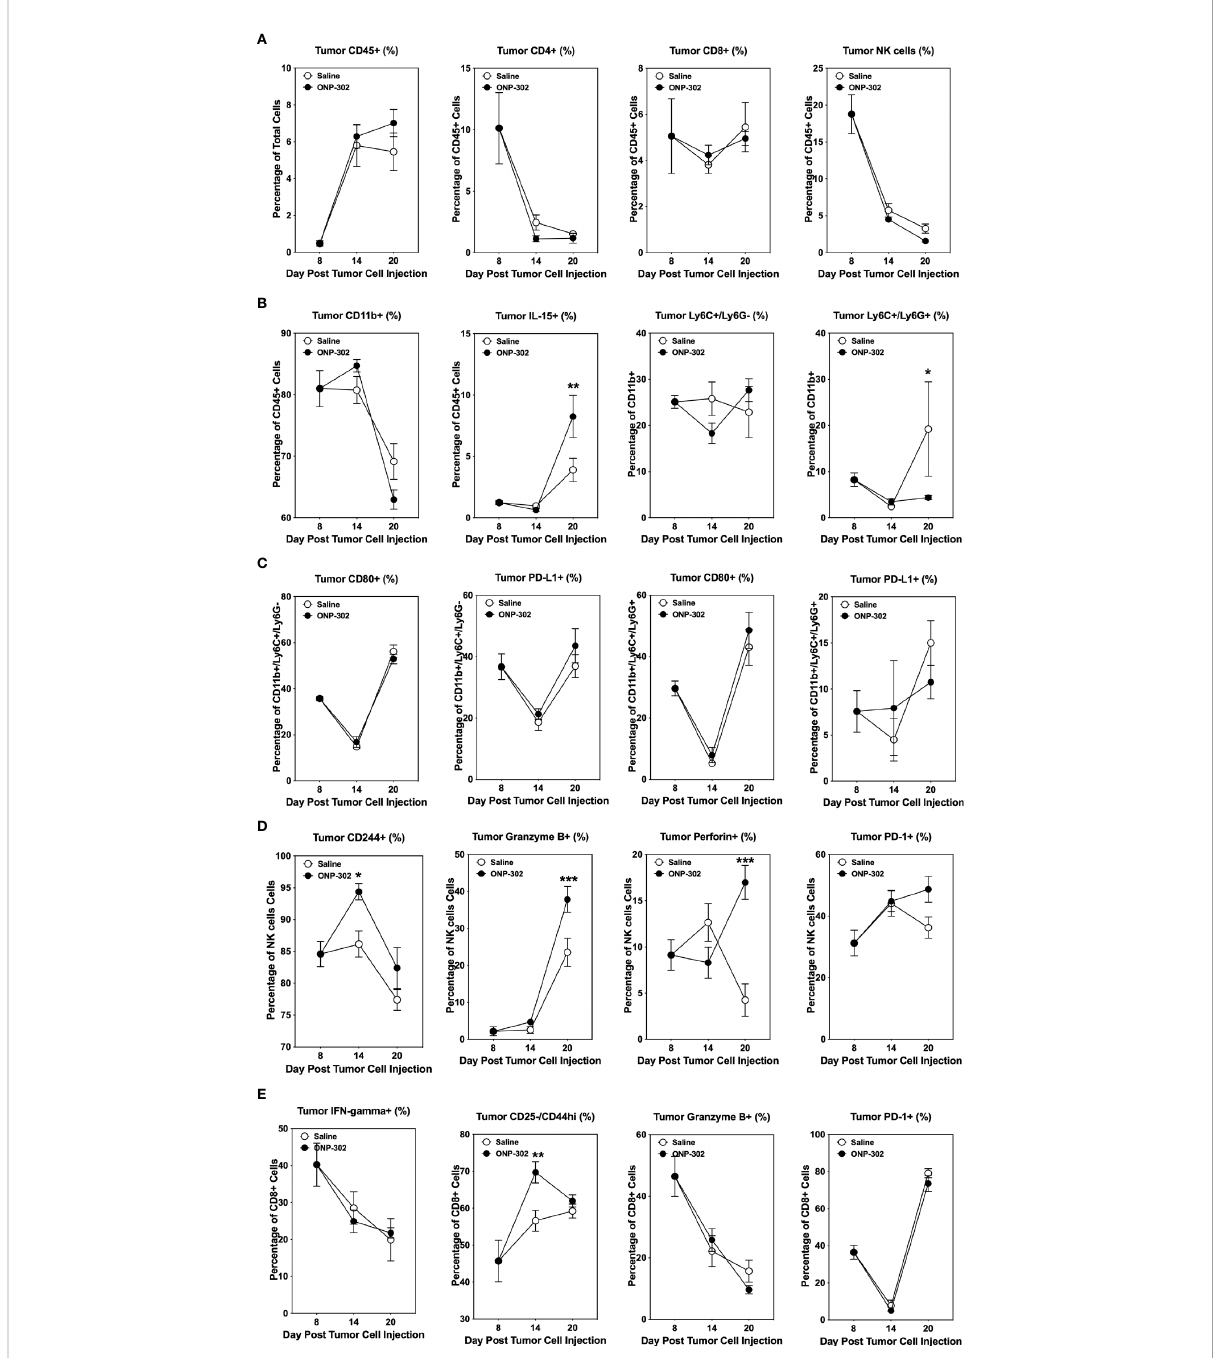
FIGURE 6 ONP-302 treatment alters immune cell populations within the tumor microenvironment (TME) of B16.F10 tumor-bearing mice over time. Naïve female C57BL/6 mice (n = 9 per treatment group) were injected s.c. with B16.F10 tumor cells. When the tumors were 50-100 mm 3 in size, mice were randomized and treated every three days with saline or ONP-302 (1.0 mg/dose in 200 m L of saline) via i.v. injection. On Day 8 (prior to the fi rst treatment), Day 14 (24 hours after the third treatment), and Day 20 (24 hours after the fi fth treatment), tumors were collected to determine the percentage of various immune cell populations present. The general lineage markers for CD45 hi , CD4 + T cells, CD8 + T cells, NK cells, CD11b + cells, Ly6C - /Ly6G + , Ly6C + /Ly6G + , and IL-15 cells are presented (A, B) . The speci fi c effector phenotypes of the myeloid (C) , NK (D) , and CD8 + T cells (E) were determined by intracellular staining. The data are presented as the mean percentage of cells ± S.E.M. One representative experiment of two is presented. Asterisks (*, **, ***) indicate a statistically signi fi cant difference as compared to saline treated mice, p < 0.05, < 0.01, and < 0.001